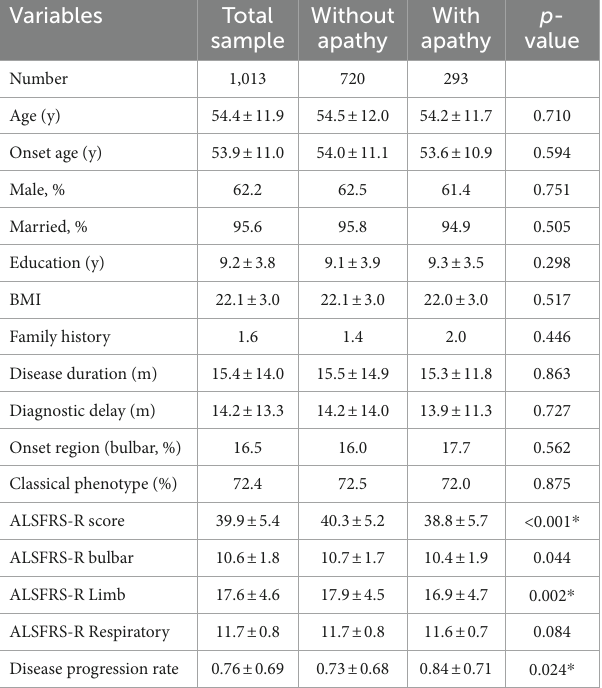
TABLE 1 Demographic and clinical features of ALS patients.